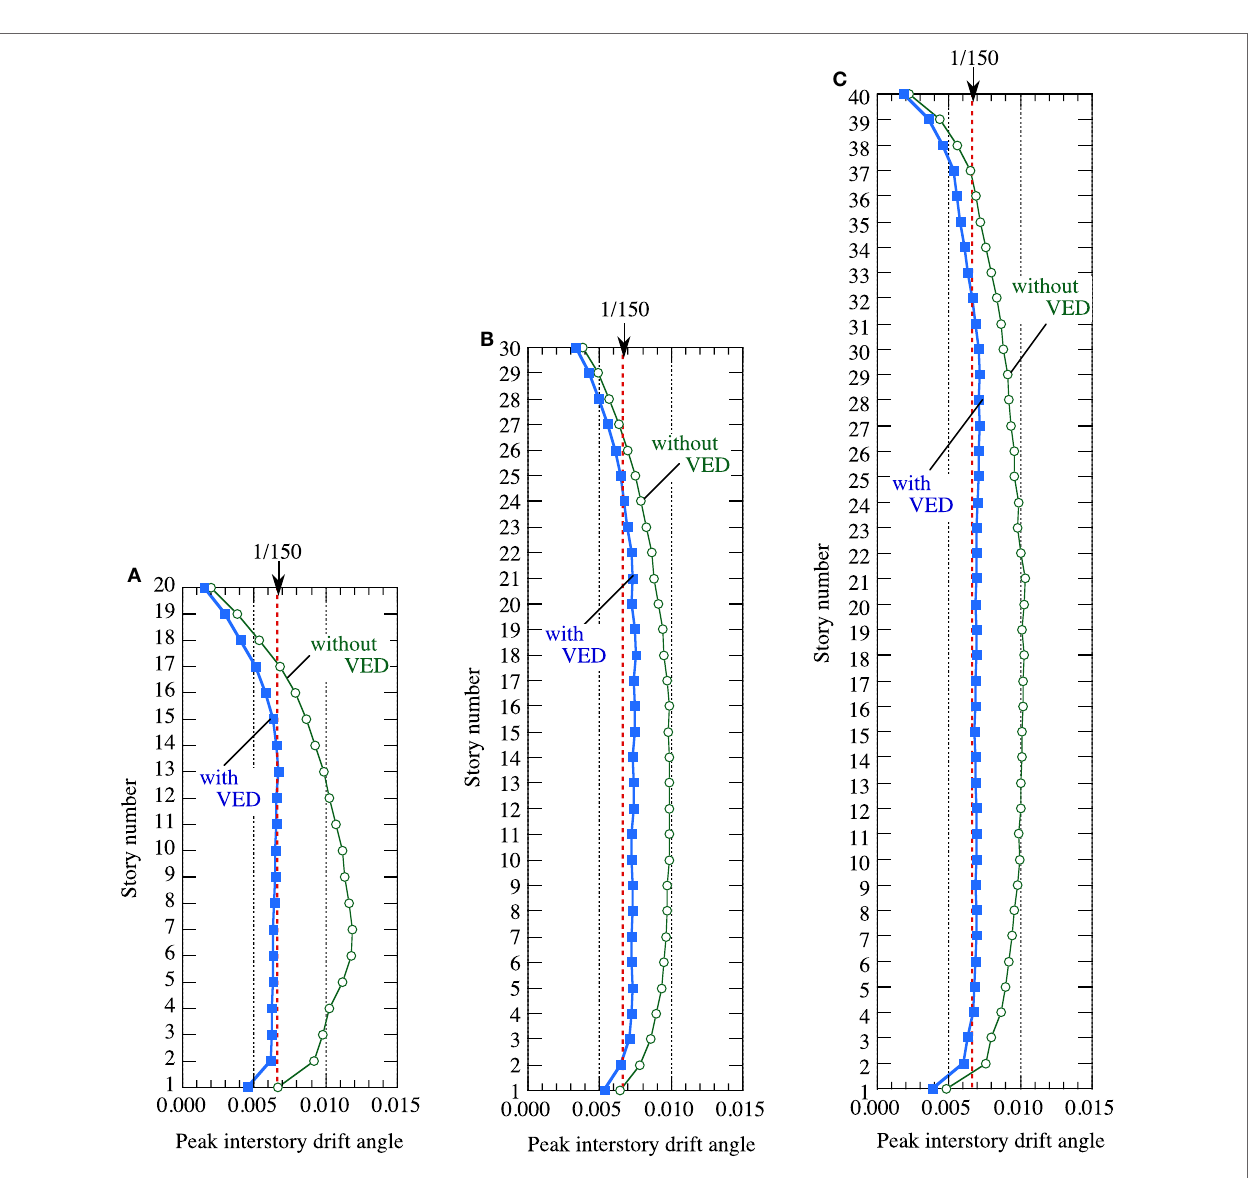
FIGURE 21 | Story-wise distribution of mean peak interstory drift angles in buildings without VEDs and buildings with VEDs designed for maximum story drift angle of 1/150 . (A) 20-story building, (B) 30-story building, and (C) 40-story